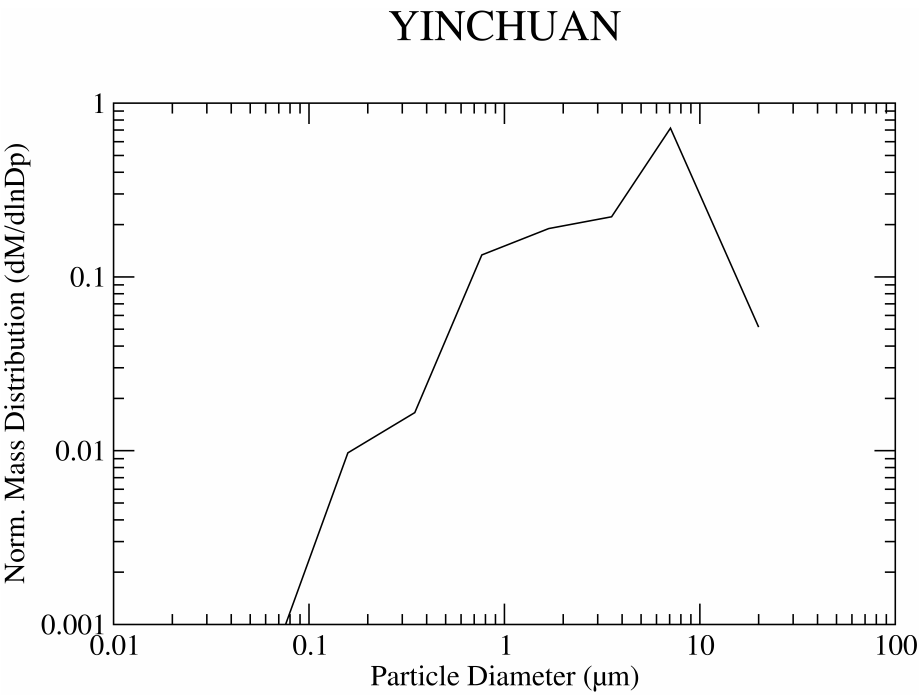
Figure 25. Average mass distribution of particles simulated by CHIMERE for the period 17